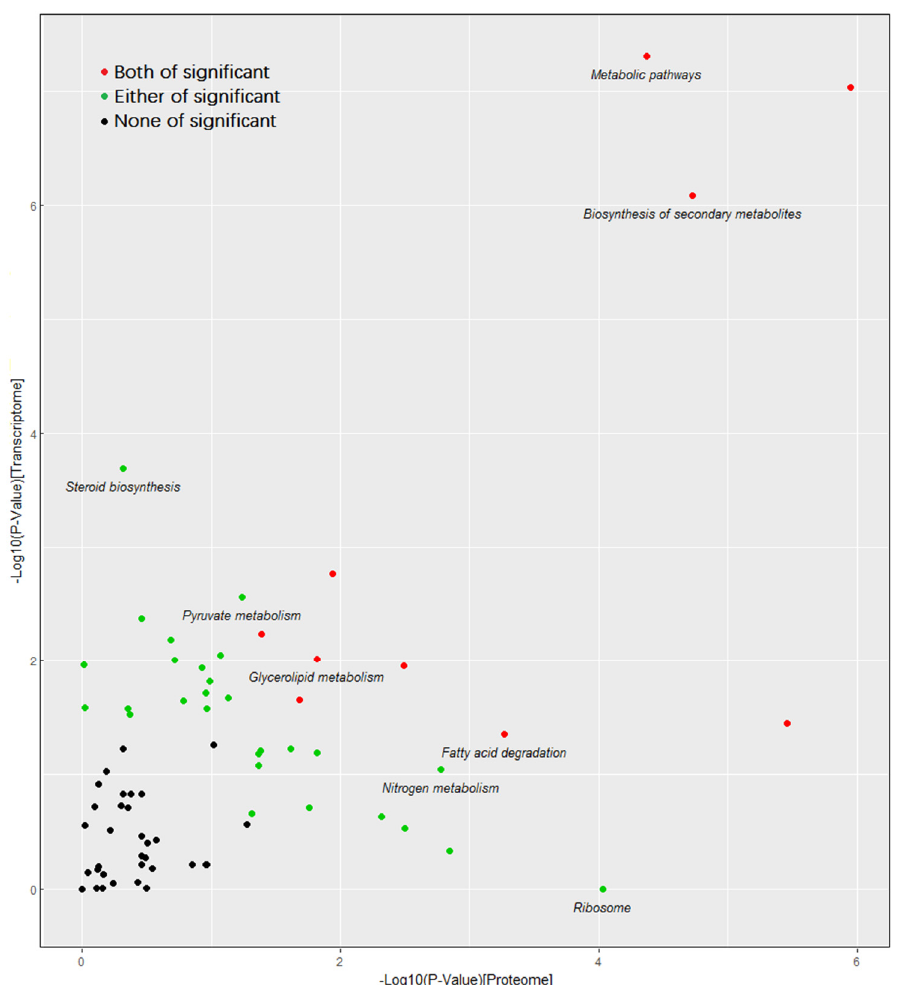
Figure 10. Scatter diagram of KEGG enrichment correlation between the datasets of proteome and transcriptome.